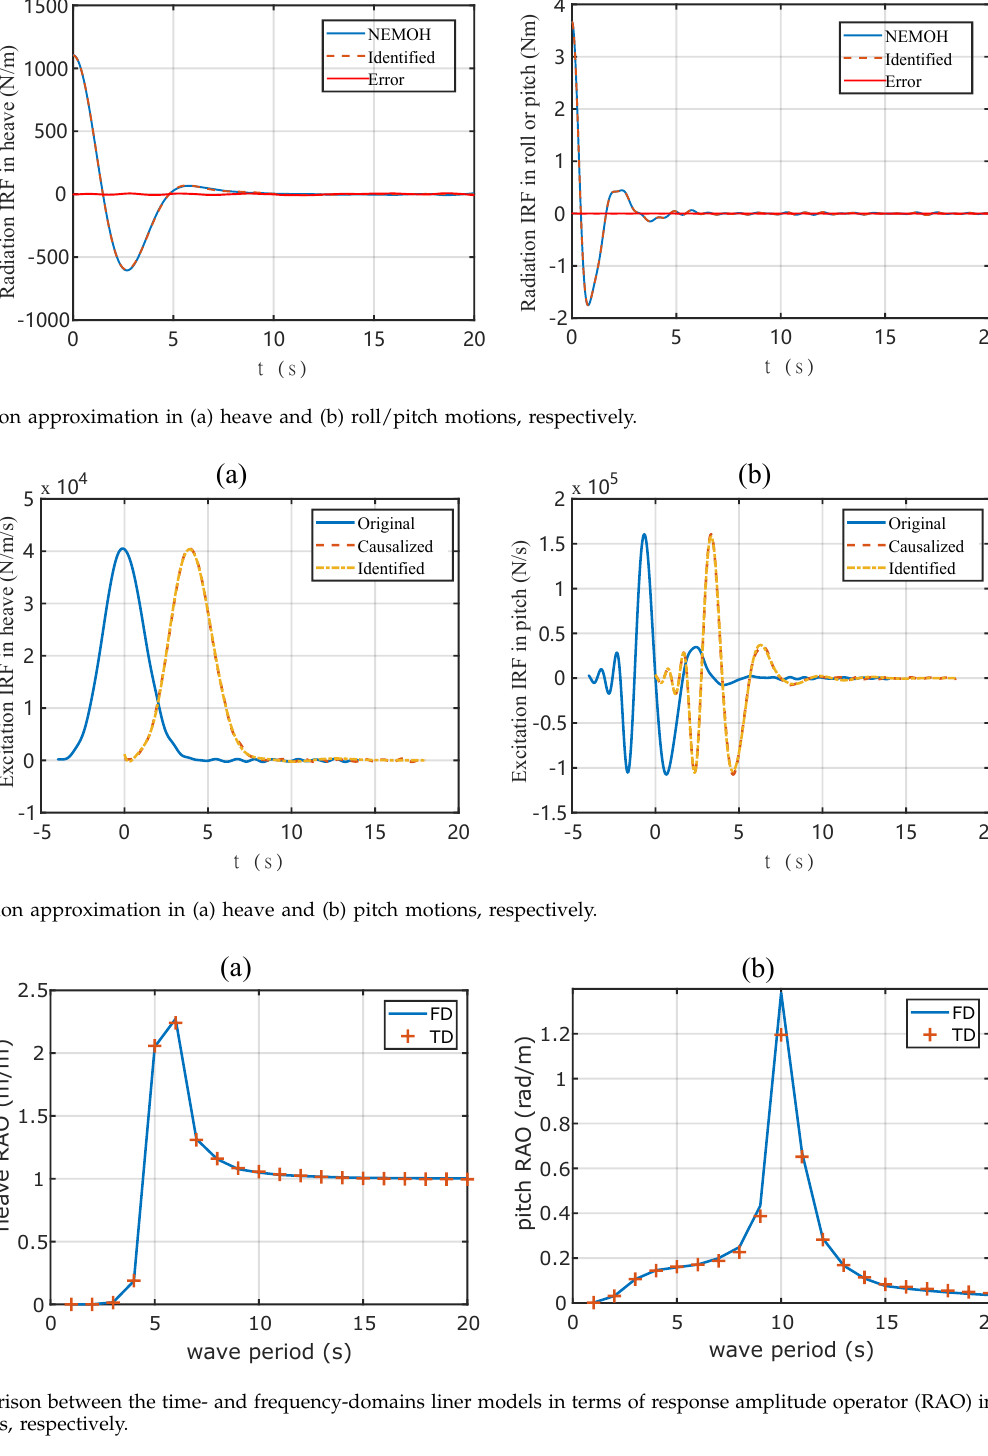
where η ( t ) is the incident wave. However, the ex- citation IRF is known to be non-causal, shown in Figs. 4(a)-(b). The approximation of the convolution term, k e ( t ) ∗ η ( t ) is not as straightforward as the ra- diation approximation. In the literature, a variety of methods are applied to approximate or estimate the excitation force [29]–[32]. In this study, the excitation force approximation proposed in [30], [31] is adopted to derive a time domain